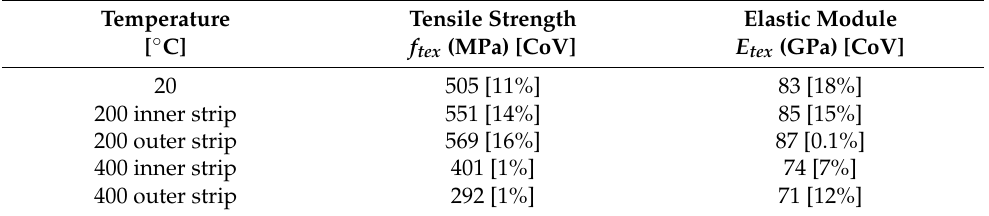
Table 4. The mechanical characteristics of the textile after its exposure to the examined temperatures along with the reference values.